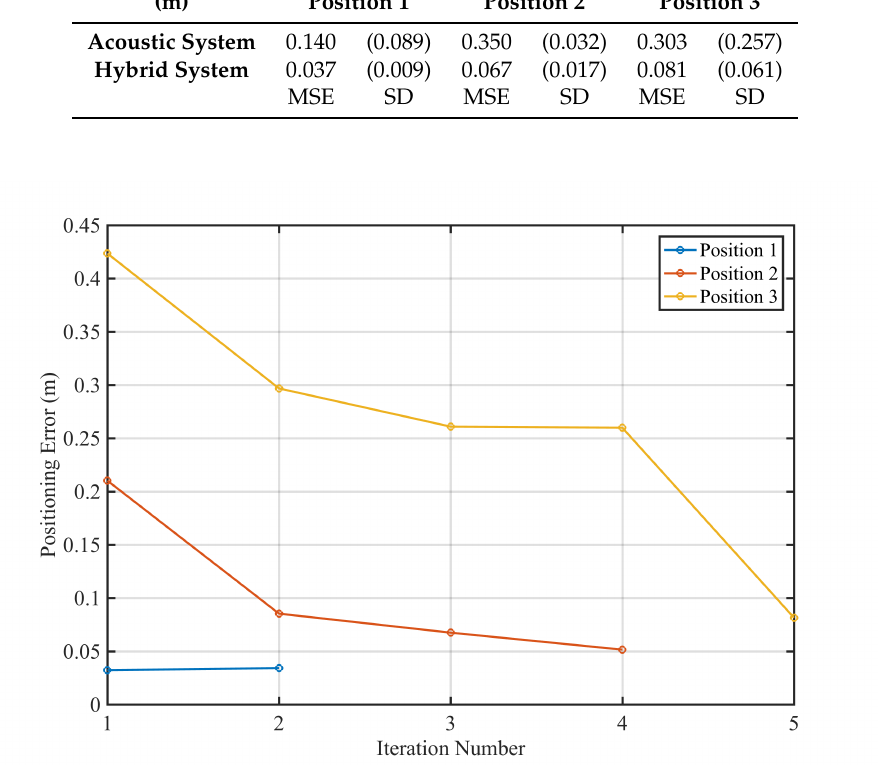
Figure 10. Number of necessary algorithm iterations to converge to a